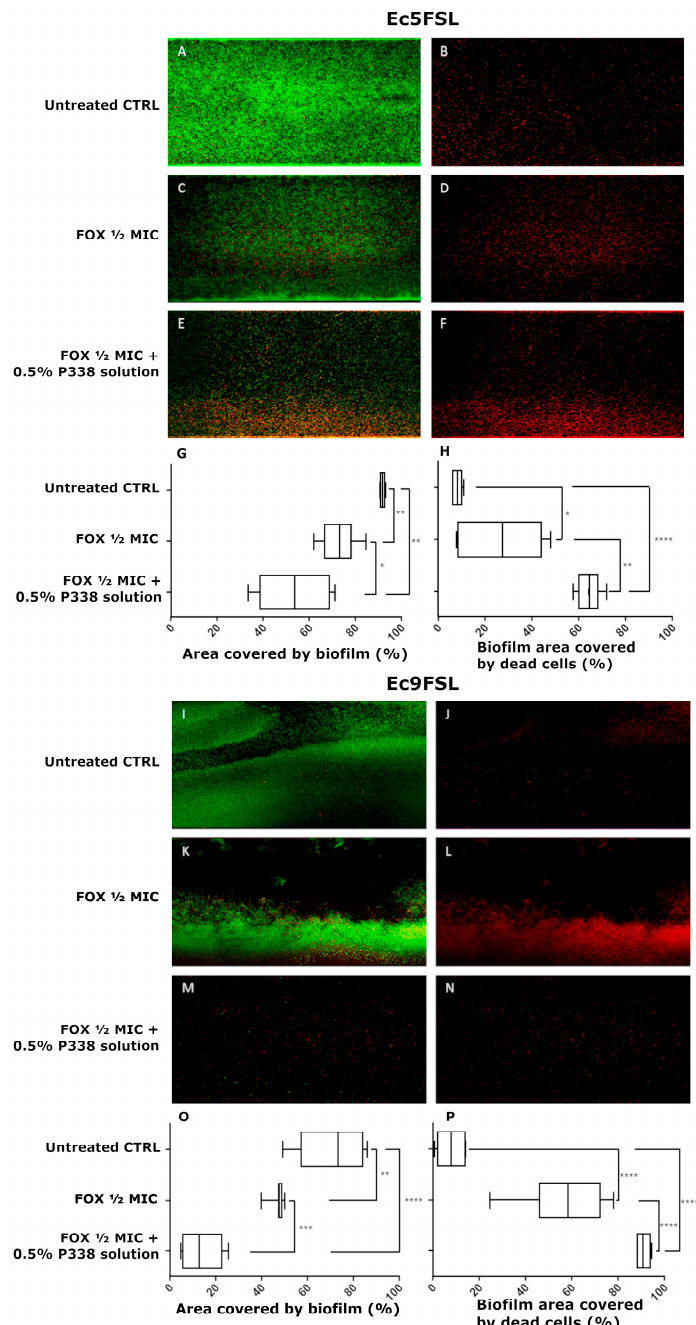
Figure 6. P338 synergizes with Cefoxitin to impair biofilm cell viability: Representative CLSM images, obtained by using the LIVE/DEAD BacLight Bacterial Viability Kit, of Ec5FSL ( A , B ) and Ec9FSL ( I , J ) biofilm controls, after 3 h of 1 MIC FOX solution instillation against mature Ec5FSL ( C , D ) 2 and Ec9FSL ( K , L ) biofilms, and after 3 h of 1 MIC FOX/0.5% P338 solution instillation against mature 2 Ec5FSL ( E , F ) and Ec9FSL ( M , N ) biofilms. Area fractions covered by biofilm (i.e., area of total biomass constituted by live and dead cells) and biofilm areas covered by dead cells (i.e., area of dead cells within the biofilm) for Ec5FSL ( G , H ) and Ec9FSL ( O , P ) isolates are graphed as percentages obtained from the mean ± s.d. of at least 4 images. Statistical significance of the percentages of each treatment and with respect to the untreated controls are represented as follows: * p -value < 0.05 (confidence interval: 95%); ** p -value < 0.01 (confidence interval: 99%); *** p -value < 0.001 (confidence interval: 99.9%); **** p -value < 0.0001 (confidence interval: